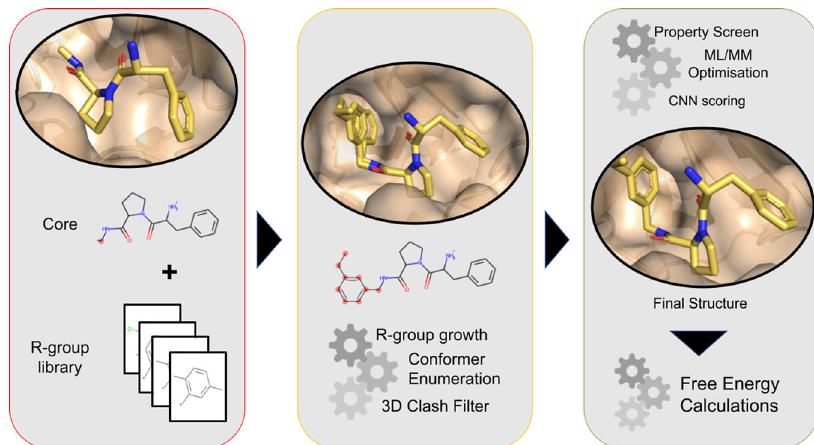
Fig. 1 Overview of the FEgrow work fl ow. (left) The user speci fi es the receptor, ligand core, and a list of functional groups, along with their attachment points. (centre) RDKit 32 is used to attach the selected R-group(s) and enumerate the available conformers with a rigid core. (right) Possible bioactive conformers undergo structural optimisation using a hybrid ML/MM potential energy function. The binding af fi nity is predicted using a convolutional neural network scoring function 47 and molecular properties are assessed. Final structures are output for further free energy based binding af fi nity